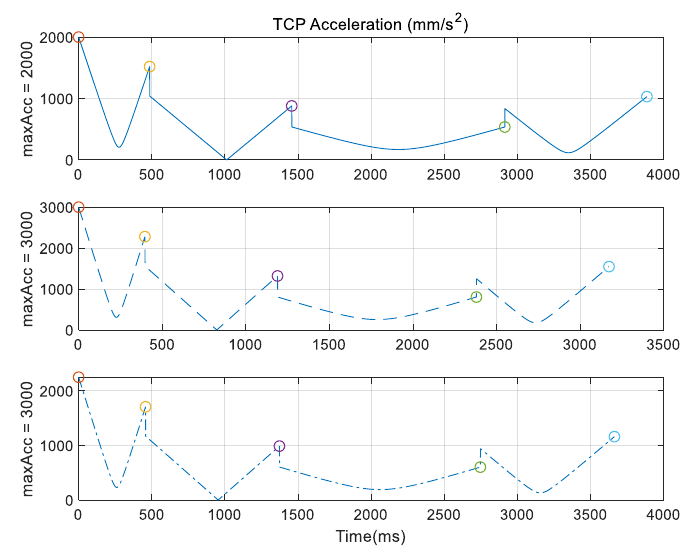
Figure 14. Acceleration when assigned maximum acceleration is changed.